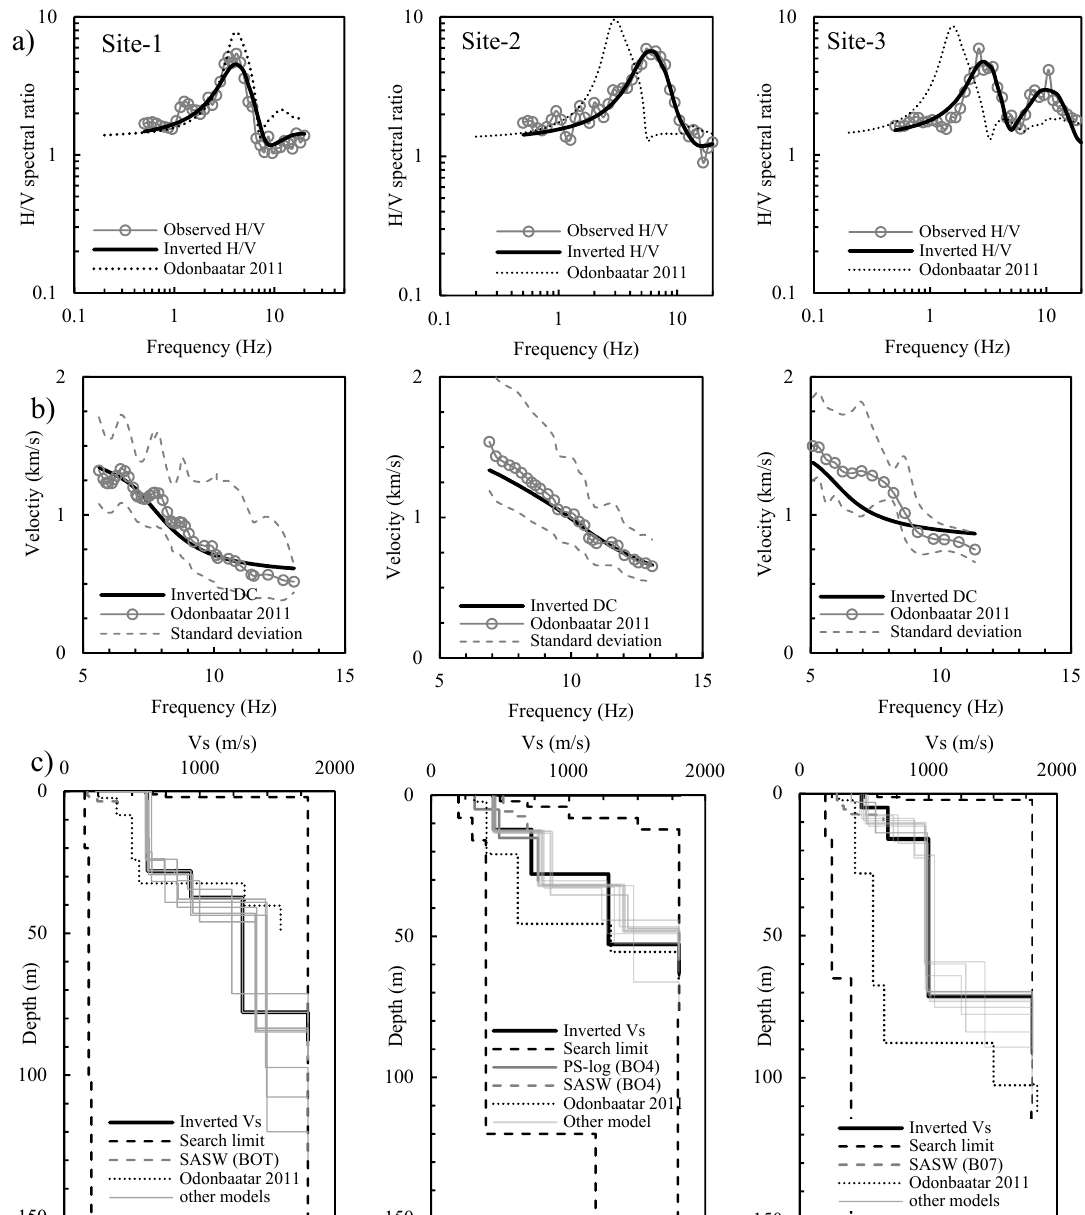
Figure 4. ( a ) Comparison of observed and theoretical and observed H/V spectral ratios; ( b ) Comparison of observed and theoretical surface wave dispersion curves and ( c ) Shear-wave velocity profiles obtained by joint inversion at Site-1, 2, and 3.